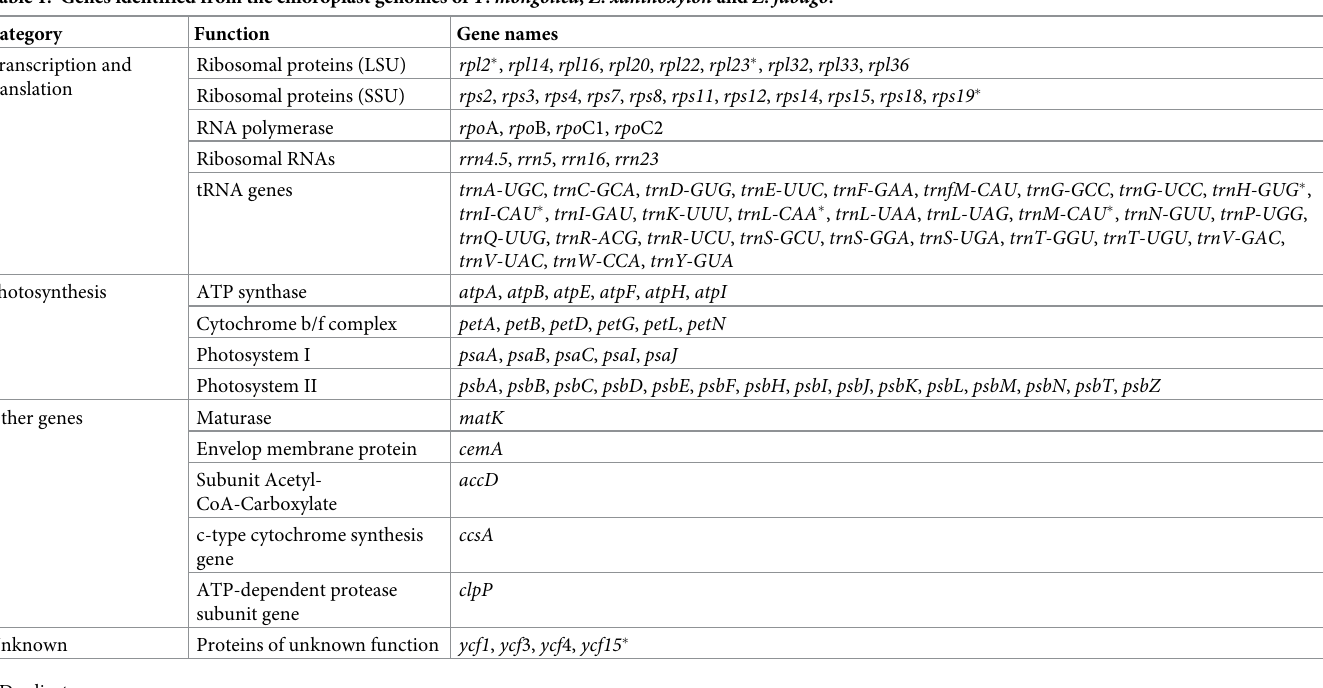
Table 1. Genes identified from the chloroplast genomes of T . mongolica , Z . xanthoxylon and Z . fabago . Category